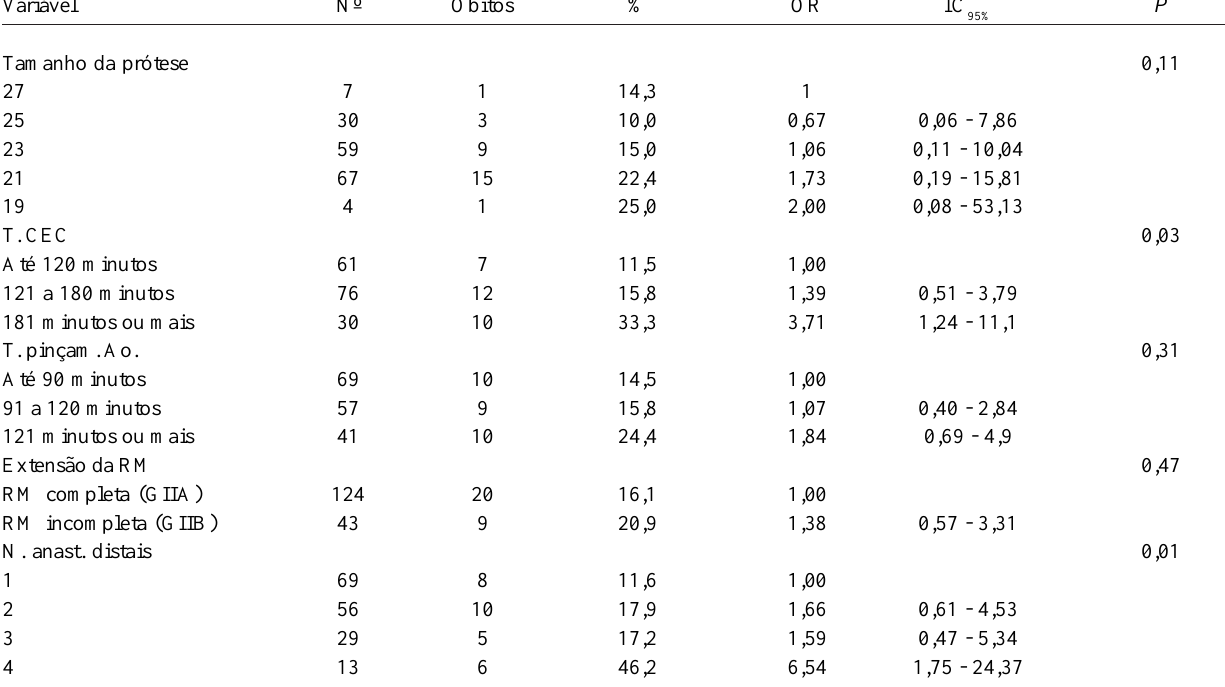
G2: portadores de EAo, associada à DAC crítica, submetidos à SVA combinada à RM. G2A: portadores de EAo, associada à DAC